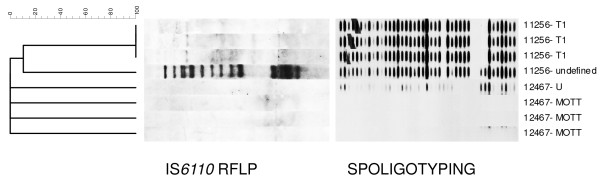
Patterns of multiple Mycobacterium spp. infections as obtained by RFLP and spoligotyping techniques. The first three isolates have only one band by RFLP (non-Beijing) and spoligotype T1; the 4th sample is a mixture of Beijing genotype (as obtained by RFLP) and spoligotype T1. The 5th sample has no RFLP banding pattern and an undefined spoligotype, whereas for the last three isolates no banding patterns were found by RFLP and spoligotyping, probably as a result of the presence of non-tuberculous mycobacteria (NTM).